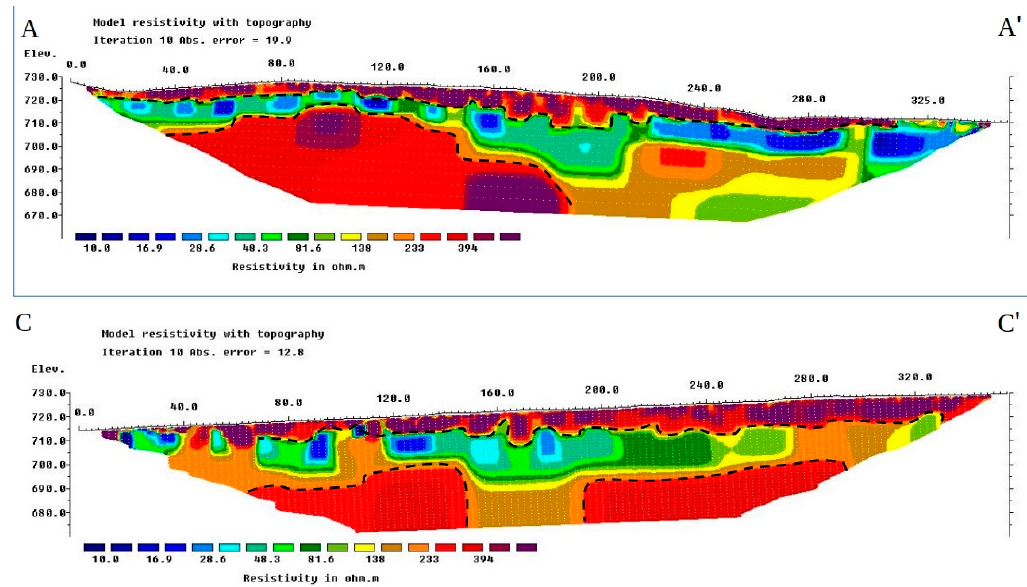
Figure 7. Electrical resistivity results collected using a dipole-dipole along A - A’ and C - C’ profile with 5 m electrode spacing covering a distance of 355 m and a depth of ~59 m. The black dotted lines show the thickness of claystone (perched aquifer).